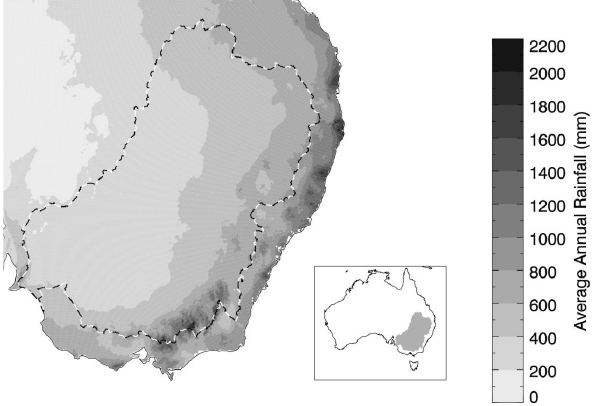
Fig. 1. The Murray-Darling Basin (dashed outline) overlaid on mean annual January–December (1900–2010) observed rainfall (mm), from the Australian Bureau of Meteorology Australian Wa- ter Availability Project rainfall grids (Jones et al., 2009a). Adapted from Draper and Mills (2008).